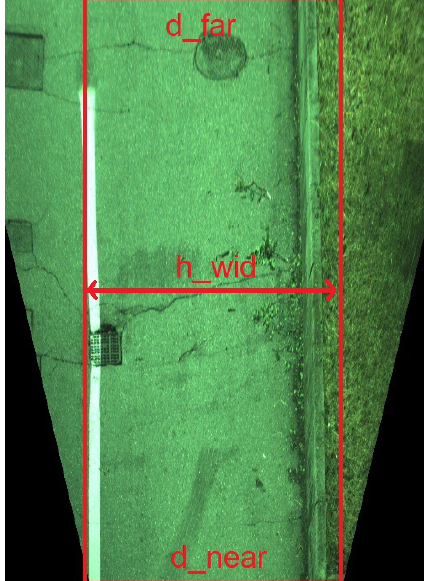
Figure 5. The orthogonal perspective transformation (@500 × 700), computed from the original Figure 3. Work area of the sweeper is highlighted. From this view, it is trivial to derive precise real world coordinates, given the scale of 1:1 pxl for cm. In the bottom of the picture ( d near ) the visible area is limited to a width of h wid , while in the upper part of the picture a larger road portion is visible.